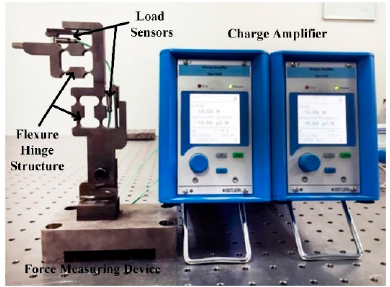
Figure 6. Force measuring device and charge amplifier.